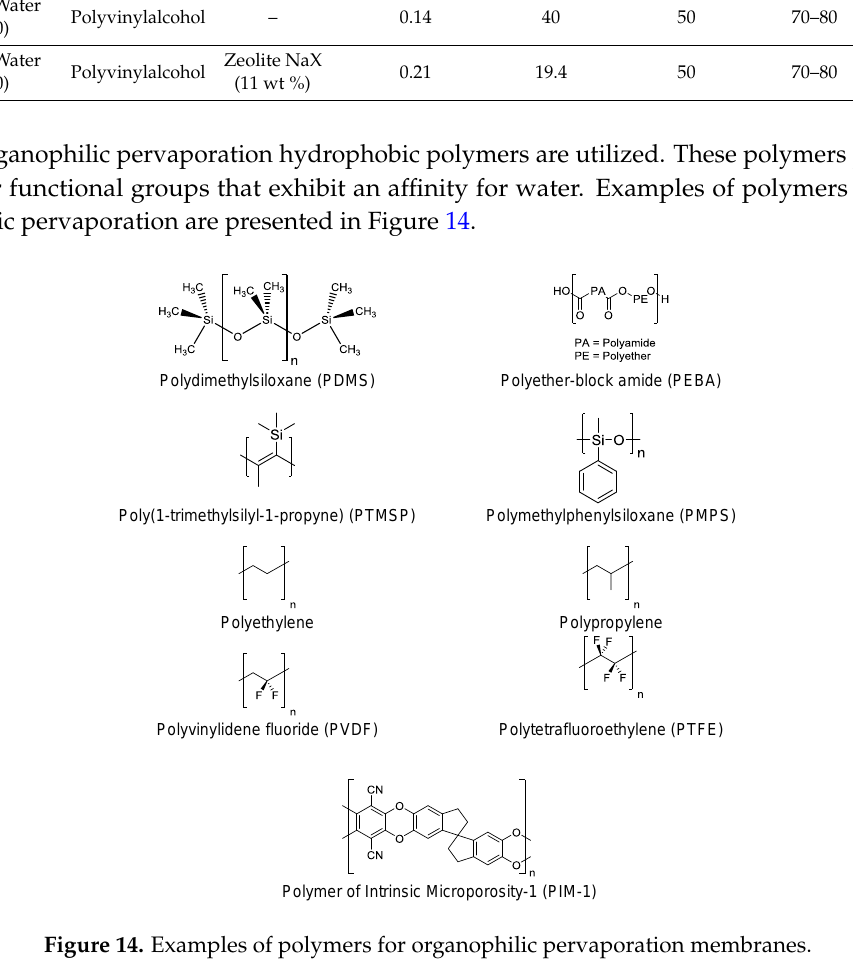
Table 2. Hydrophilic pervaporation of ethanol-water mixtures by various polymer membranes.